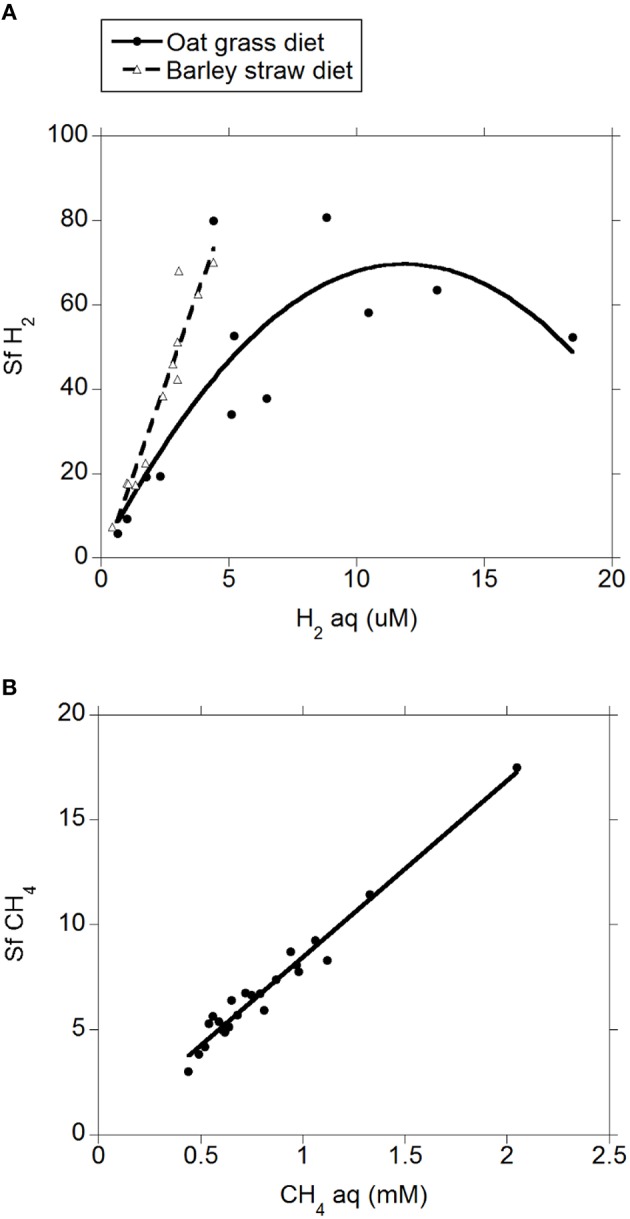
Relationship between saturation factor and dissolved gases concentration. (A)
Sf H2 = 8.29 (±4.89; P = 0.11) ± 14.9 (±4.16; P = 0.002) diet + 11.2 (±1.57; P < 0.001) H2 (aq) − 0.48 (±0.12; P < 0.001) (H2 (aq) − 4.42)2 ± 3.936 (H2 (aq) − 4.42) × diet; R2 = 0.78 (P < 0.001); (B)
Sf CH4 = 0.048 (±0.30; P = 0.87) + 8.42 (±0.34; P < 0.001) CH4 (aq); R2 = 0.97; P < 0.001).